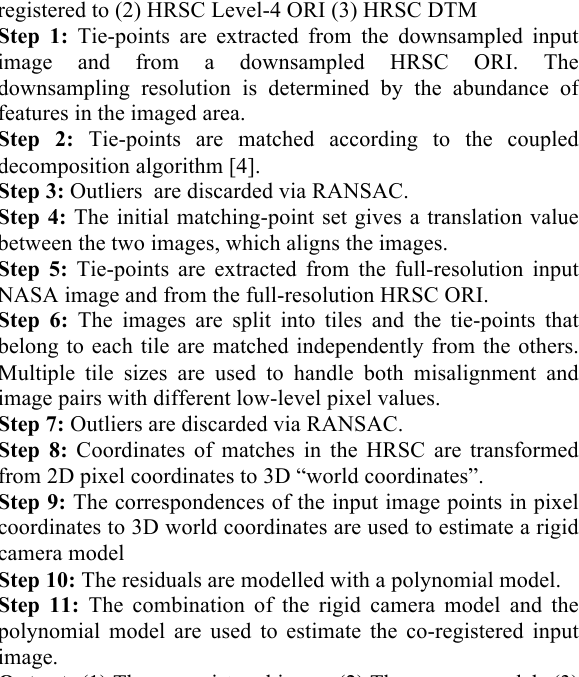
Figure 2. Multi-instrument co-registration